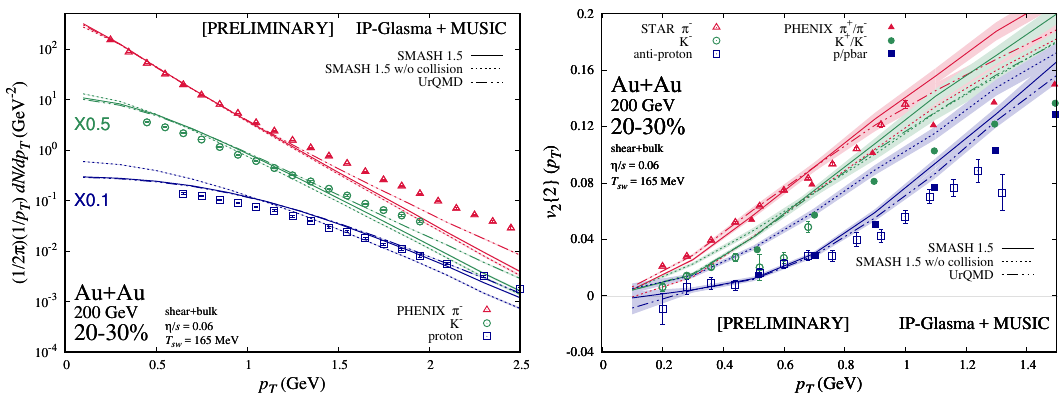
Figure 2. The identified hadron p T -spectra ( left ) and differential elliptic flows ( right